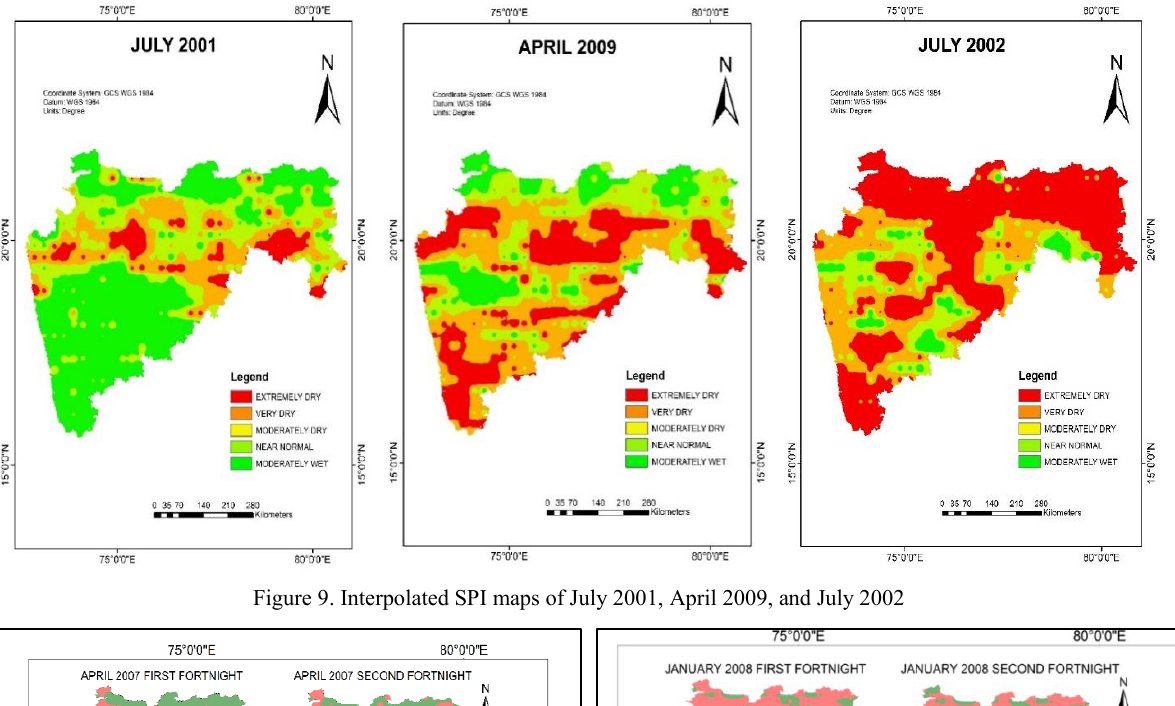
Figure 9. Interpolated SPI maps of July 2001, April 2009, and July 2002